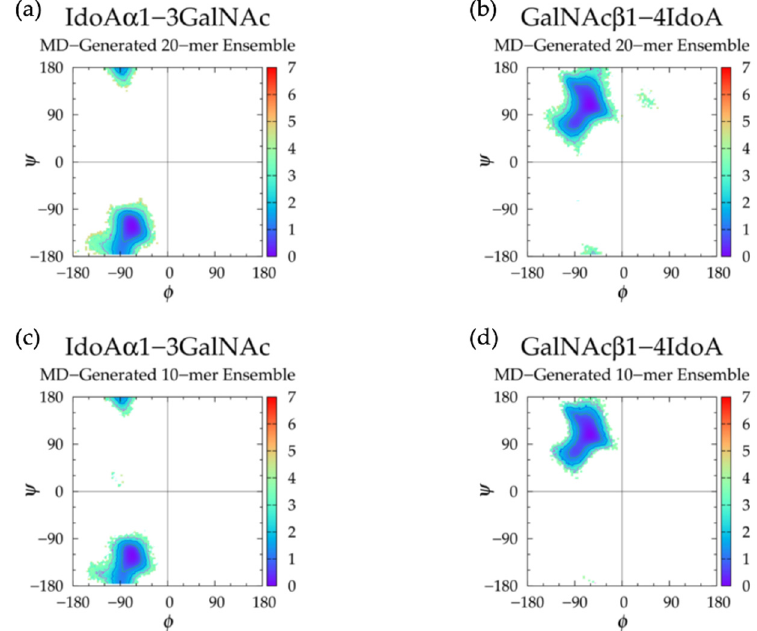
Figure 11. ∆ G ( φ , ψ ) in the MD-generated nonsulfated dermatan ensembles for aggregated IdoA α 1-3GalNAc and GalNAc β 1-4IdoA glycosidic linkage data in the ( a , b ) 20-mer and ( c , d ) 10-mer, respectively; contour lines every 1 kcal / mol. Table 4. Nonsulfated Dermatan Glycosidic Linkage Dihedrals ( φ , ψ ) 1 and Free Energy ( ∆ G ( φ , ψ ) kcal / mol) Minima.